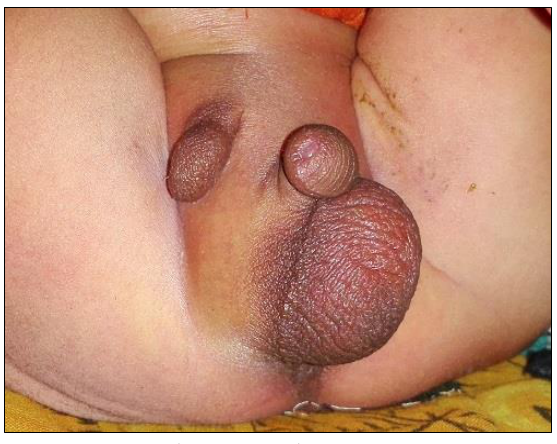
Figure 1: Ectopic